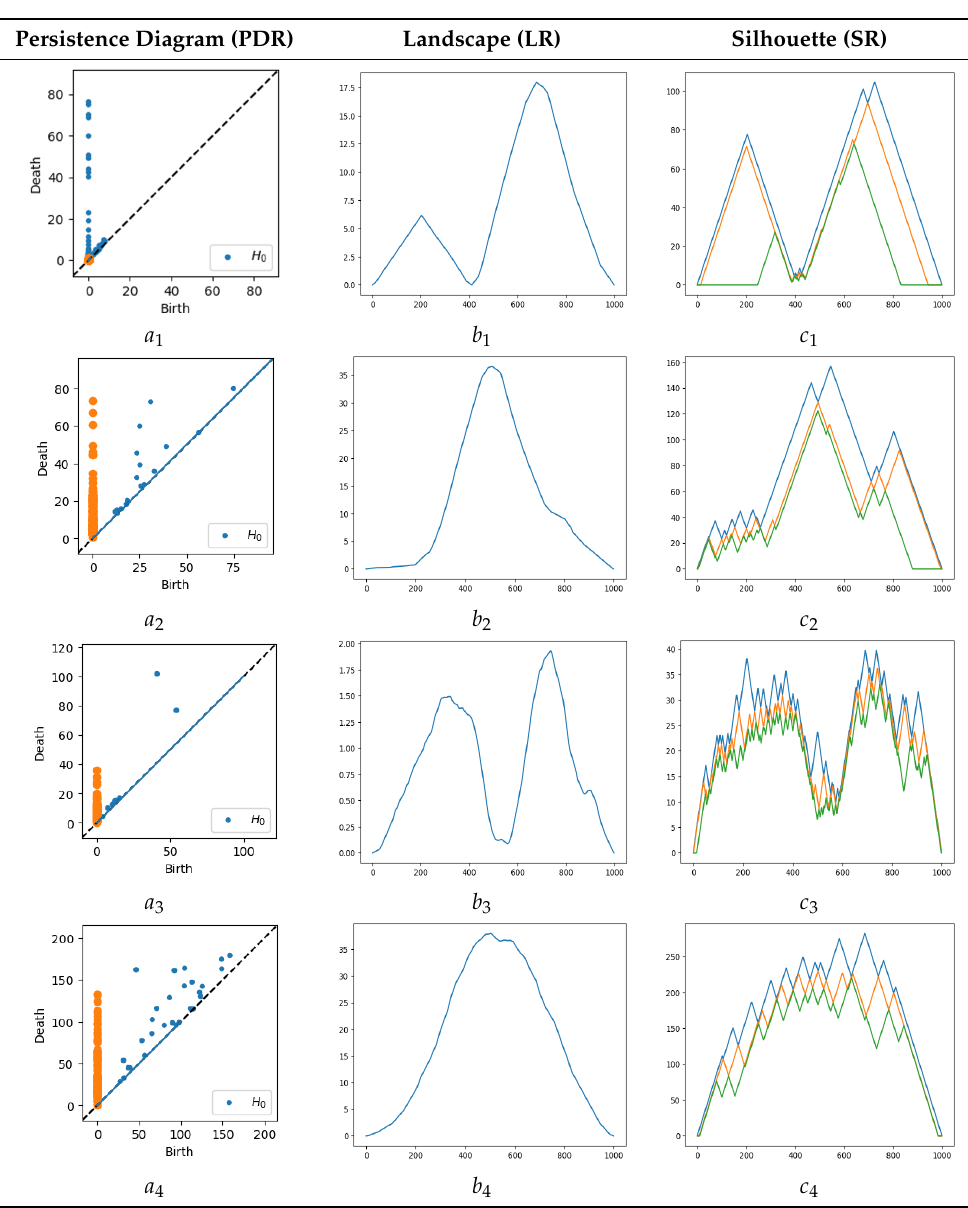
Table 2. From top to bottom, left to right: a 1 , a 2 , a 3 and a 4 illustrate Persistence Diagrams (PDR). b 1 , b 2 , b 3 and b 4 show Persistence Landscapes representation (LR), while c 1 , c 2 , c 3 and c 4 detail Weighted Silhouette representation (SR). These all correspond to the four classes Normal , Other , VT and VF ,